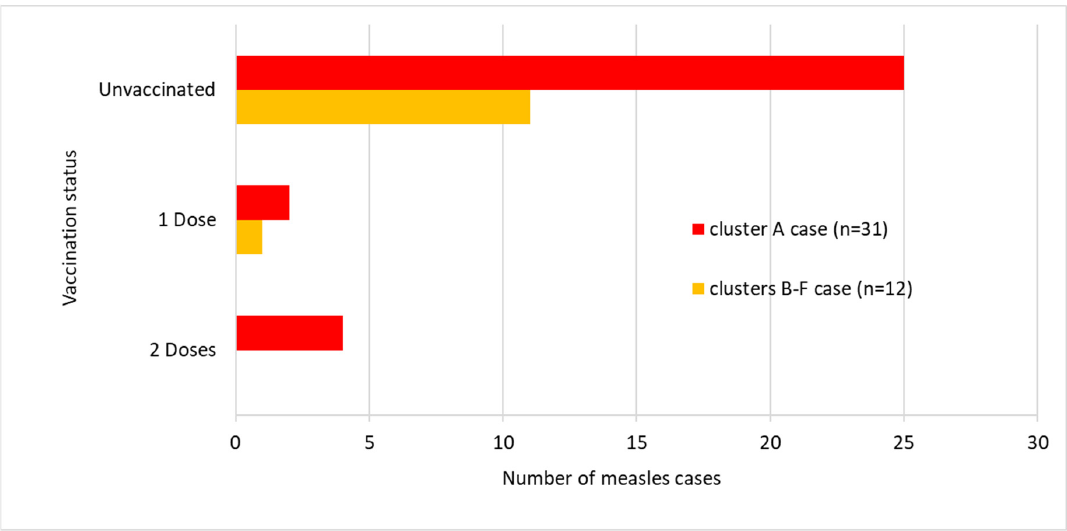
Figure 4. Measles vaccine ‐ eligible cases according to vaccination status and cluster, Austria, January– March 2019 (n = 43).